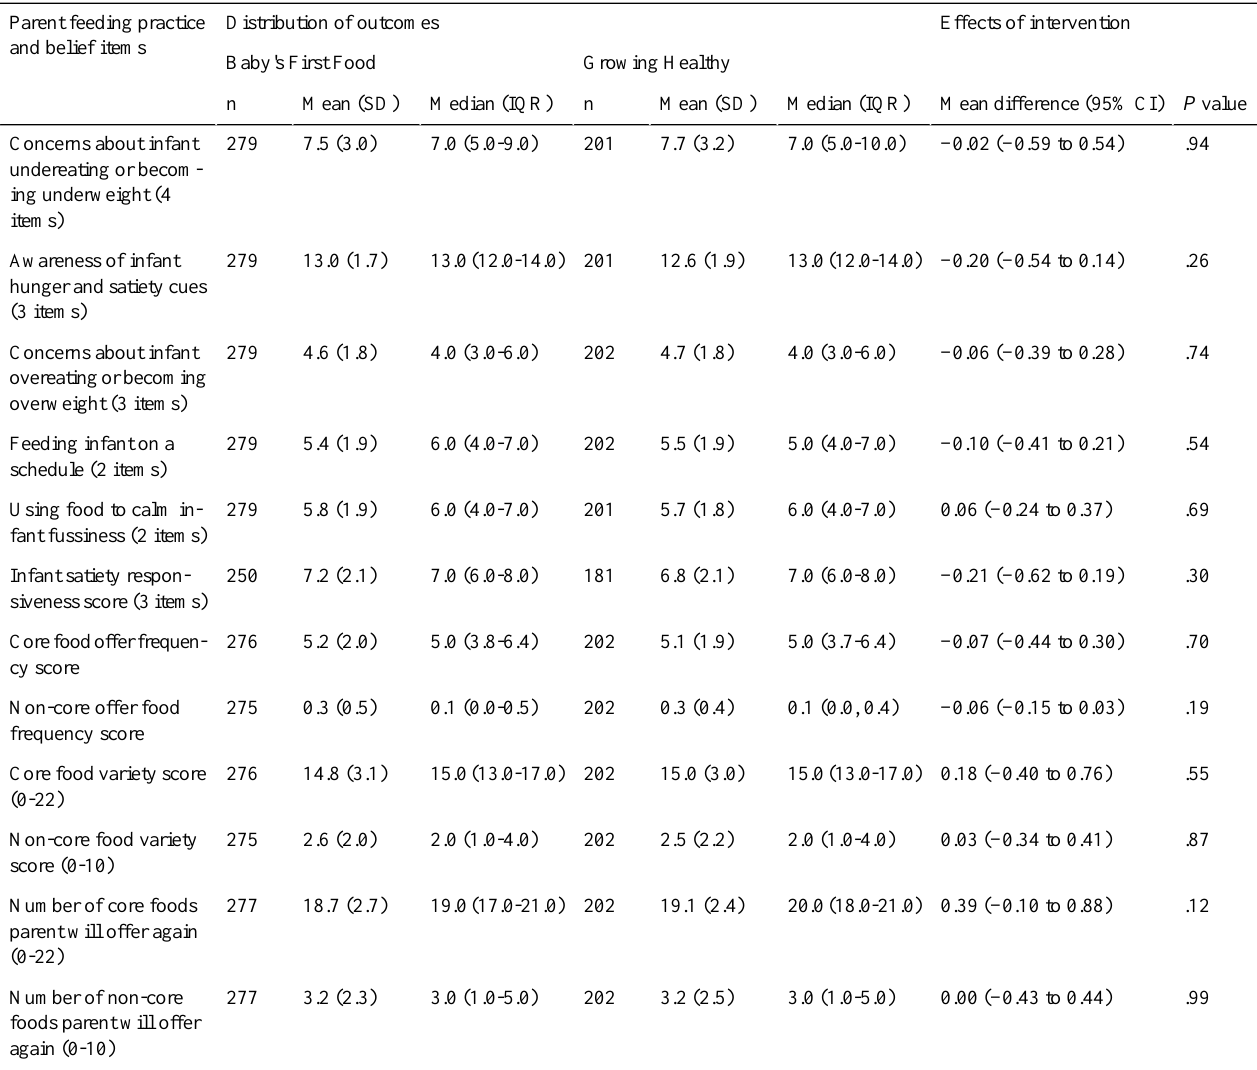
Table 4. Comparison of parent feeding practice and beliefs, dietary exposure, and infant food preference continuous outcomes at time 3 between Baby's First Food and Growing Healthy. Mean difference coefficients estimated from linear regression analysis. IQR: interquartile range.